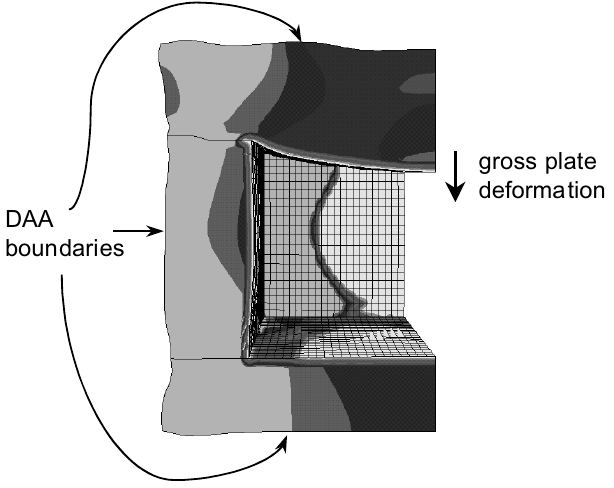
Fig. 7. Finite element pressure-fringe plot for Model #2 (not hydrostatically initialised, HYDPRE (cid:3) = 0) at 5.39 ms showing the erroneous pressure build-up in the fluid region (structural mesh removed for illustrative purposes) and the subsequent gross distortion of the fluid mesh at the fluid-structure interface. Light and dark regions indicate low and high pressures, respectively over an approximate range of 0 to 10 MPa. effectively reduces the overall load applied to the